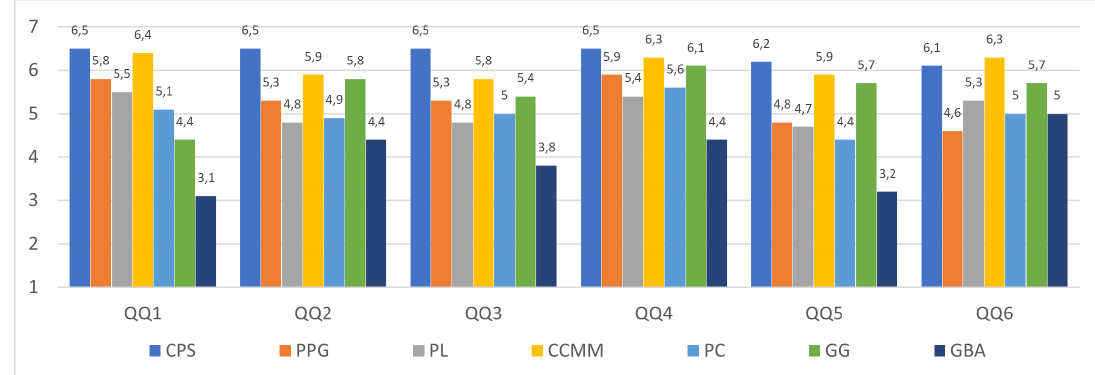
Figure 5: Mean scores of sites per each of the six items of the QA